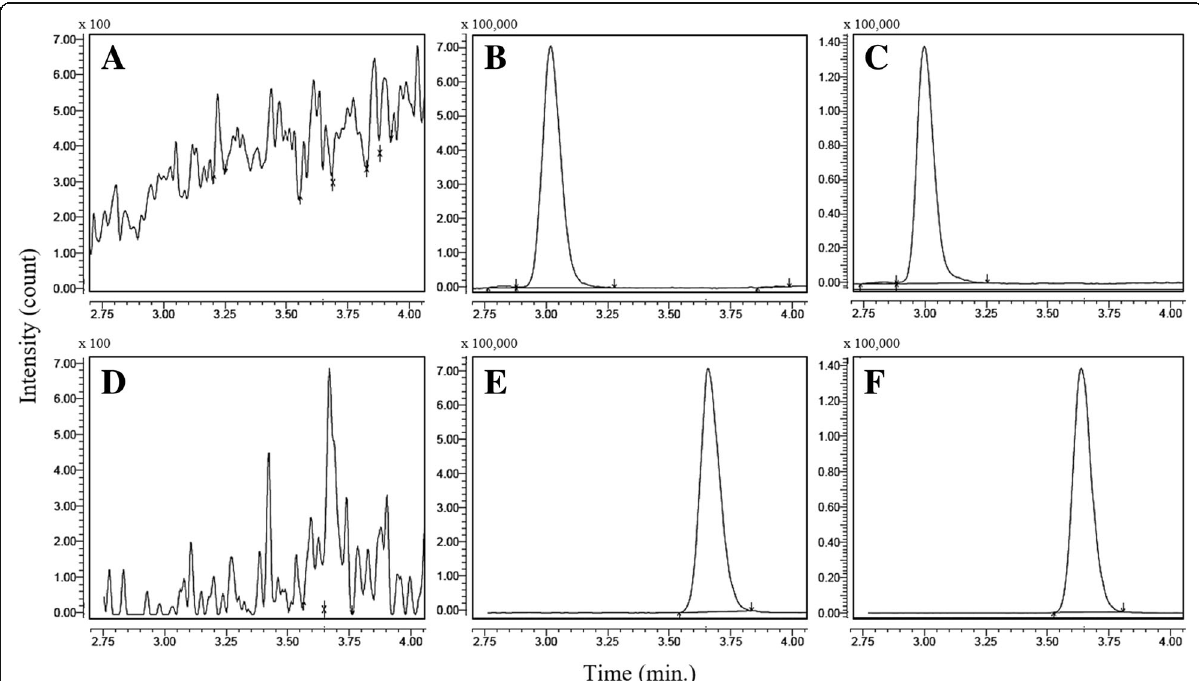
Fig. 2 Representative chromatograms of blank rat plasma after monitoring under cucurbitacin B condition ( a ); blank plasma with cucurbitacin B at 5 μ g/L ( b ); cucurbitacin B in an unknown plasma sample ( c ); blank rat plasma after monitoring under glycyrrhizic acid condition ( d ); pre-spiked blank plasma with glycyrrhizic acid at 25 ng ( e ); glycyrrhizic acid added in an unknown plasma sample ( f